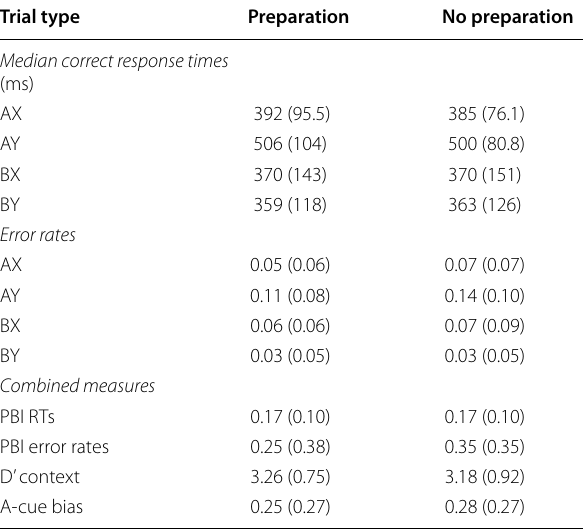
Table 2 Descriptive statistics for the AX-CPT as a function of preparation condition (Prep or No